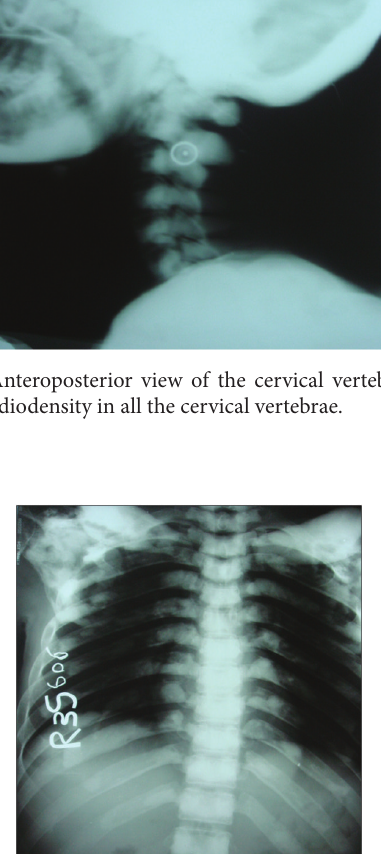
Figure 9: Anteroposterior view of the pelvis showing expanding osteosclerosis of the pelvic bone and the iliac